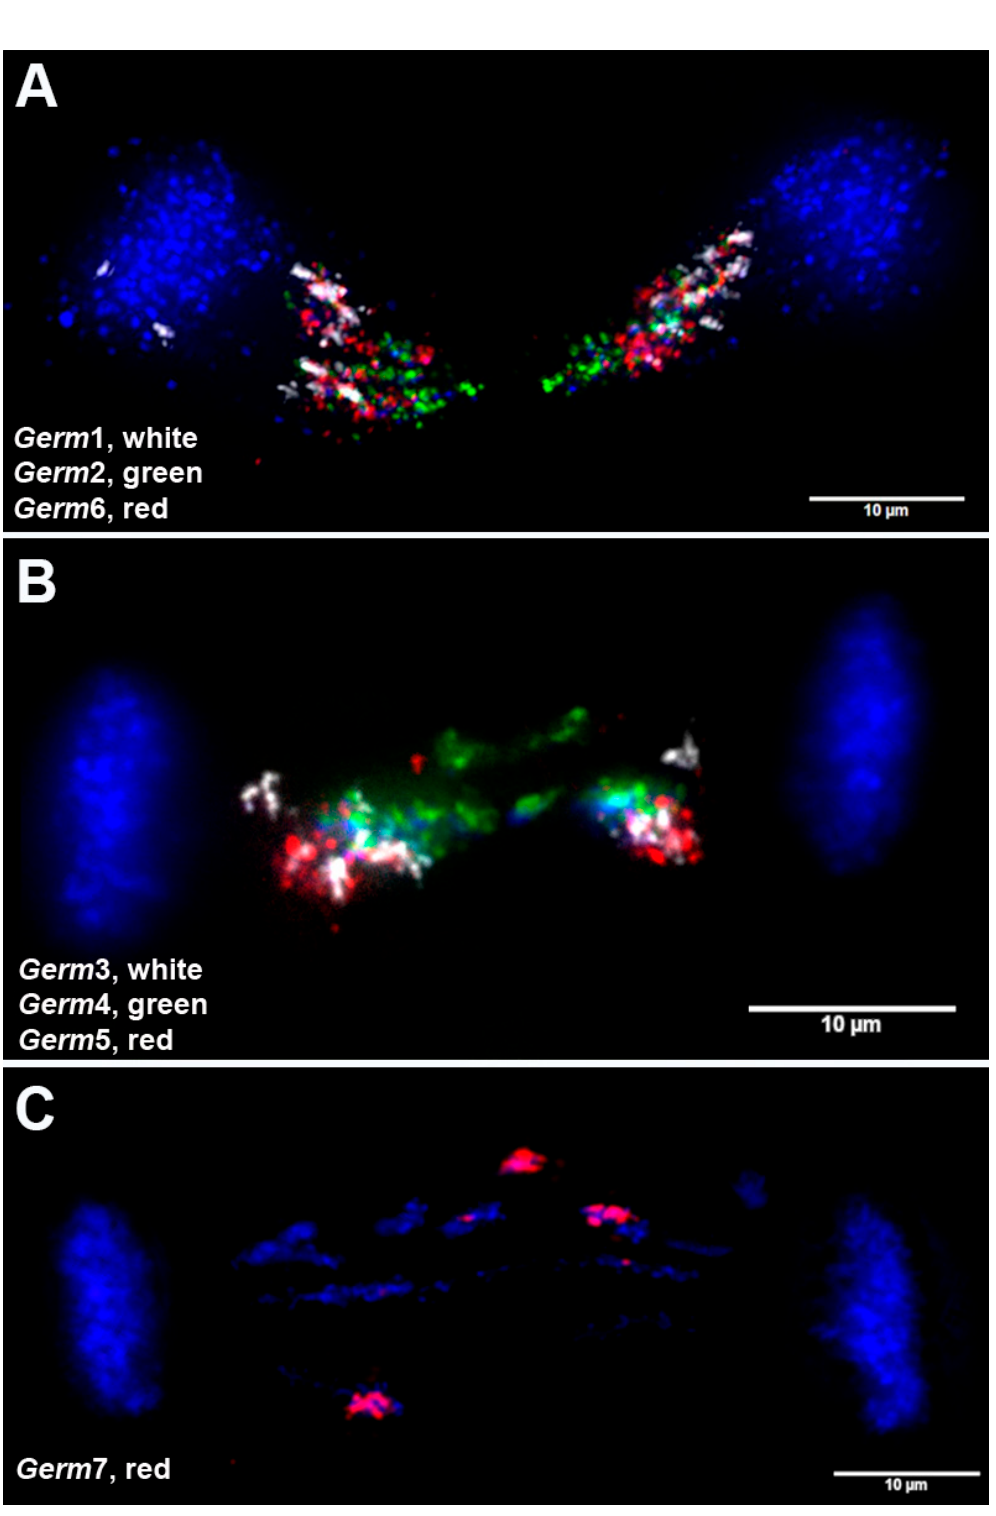
Figure 5. Lagging chromosomes and germline-restricted repeats. Representative examples from FISH of seven repetitive elements to lagging anaphases from 1.5 dpf sea lamprey embryos: ( A ) Germ1 (white), Germ2 (green), Germ6 (red); ( B ) Germ5 (red), Germ4 (green), Germ3 (white); ( C ) Germ7 (red).